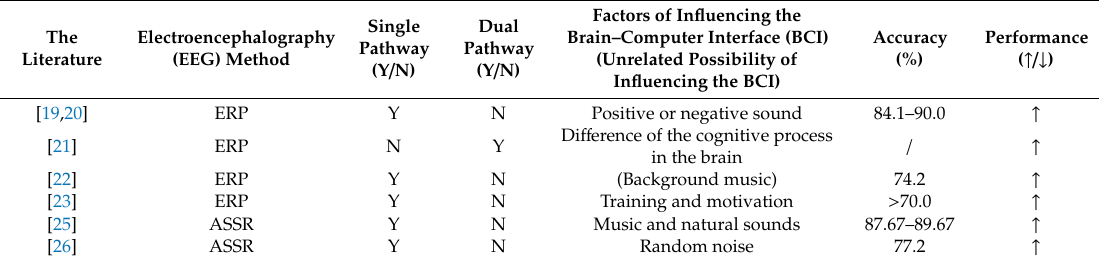
Table 1. Lists of studies on influence of sound on